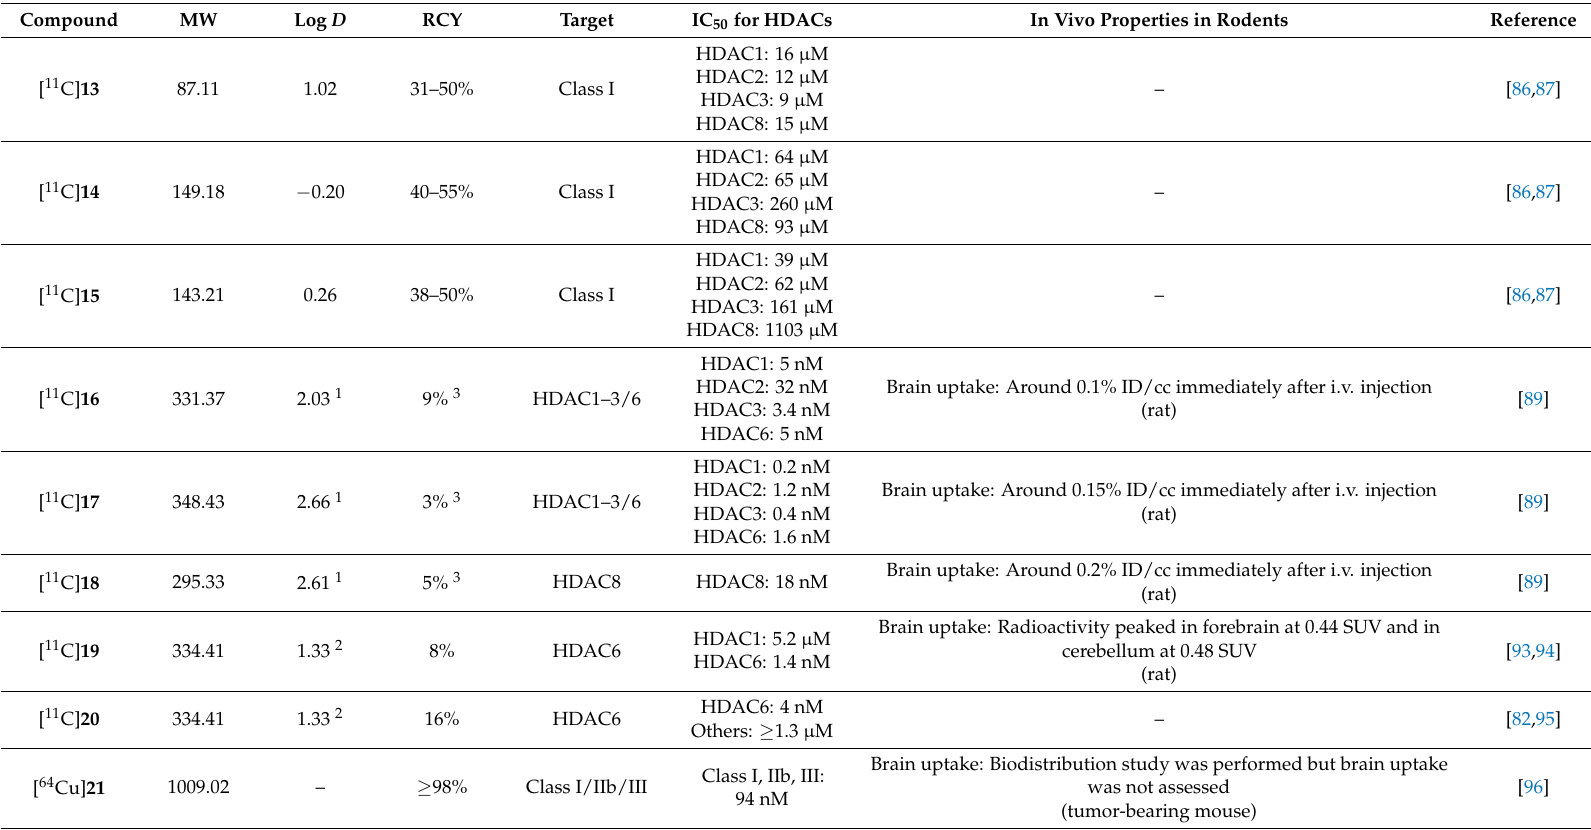
Table 3. Physiochemical properties of radiolabeled carboxylic acid- and hydroxamic acid-based HDAC ligands. Compound IC 50 for HDACs In Vivo Properties in Rodents